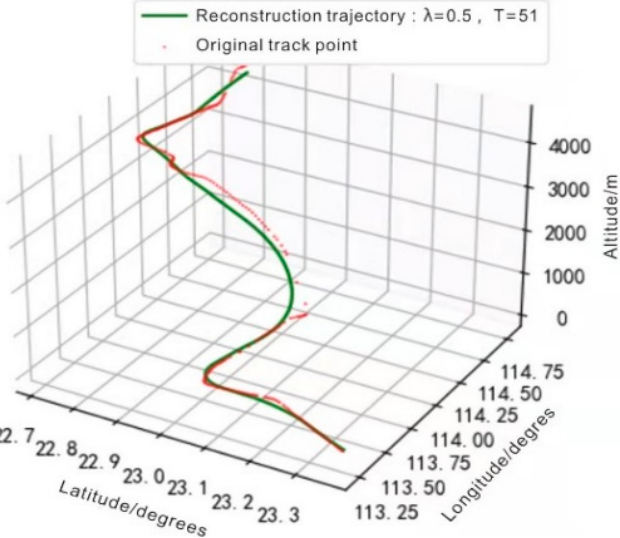
Figure 5. Reconstruction trajectory. ( A ) Reconstruction trajectory with λ = 0.5, T = 51. ( B ) Reconstruc- tion trajectory with λ = 0.2, T = 91.